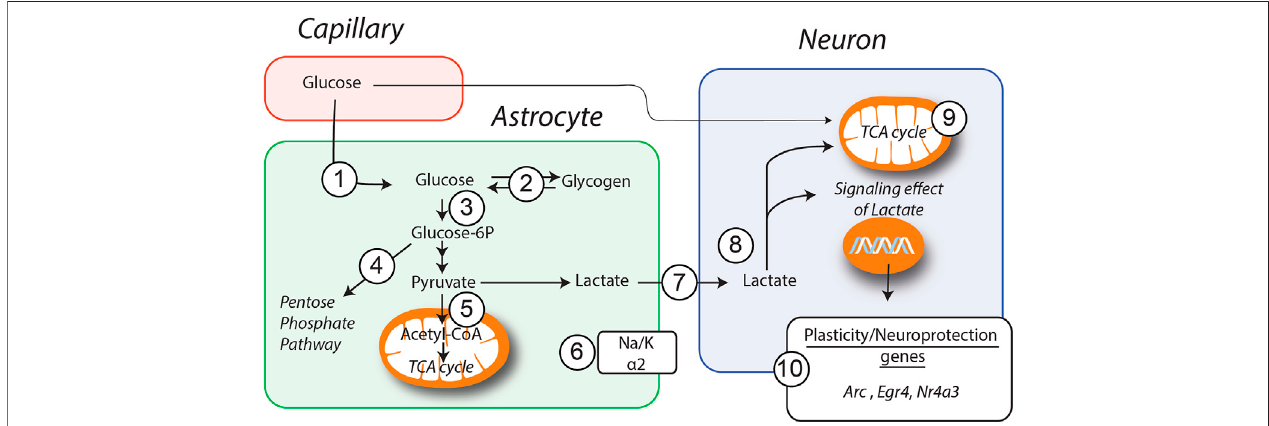
FIGURE 7 | Schematic representation of GM1 metabolic effects in astrocytes and neurons. Models of how GM1 induces glucose entry (1) and glycogen mobilization (2) inastrocytes, leads tothe upregulationof Ptg (2), Hk (3), Taldo (4), Pdh (5)and Na + /K + atpase subunit α 2 (6) genes, enhances secretion of lactate (7)and itstransfertoneurons(8).Whenneuronsareculturedinpresenceofastrocytes,treatmentwithGM1leadstoincreasedneuronalmitochondrialactivity(9)andexpression of a number of genes including Arc , Egr4 and Nr4a3